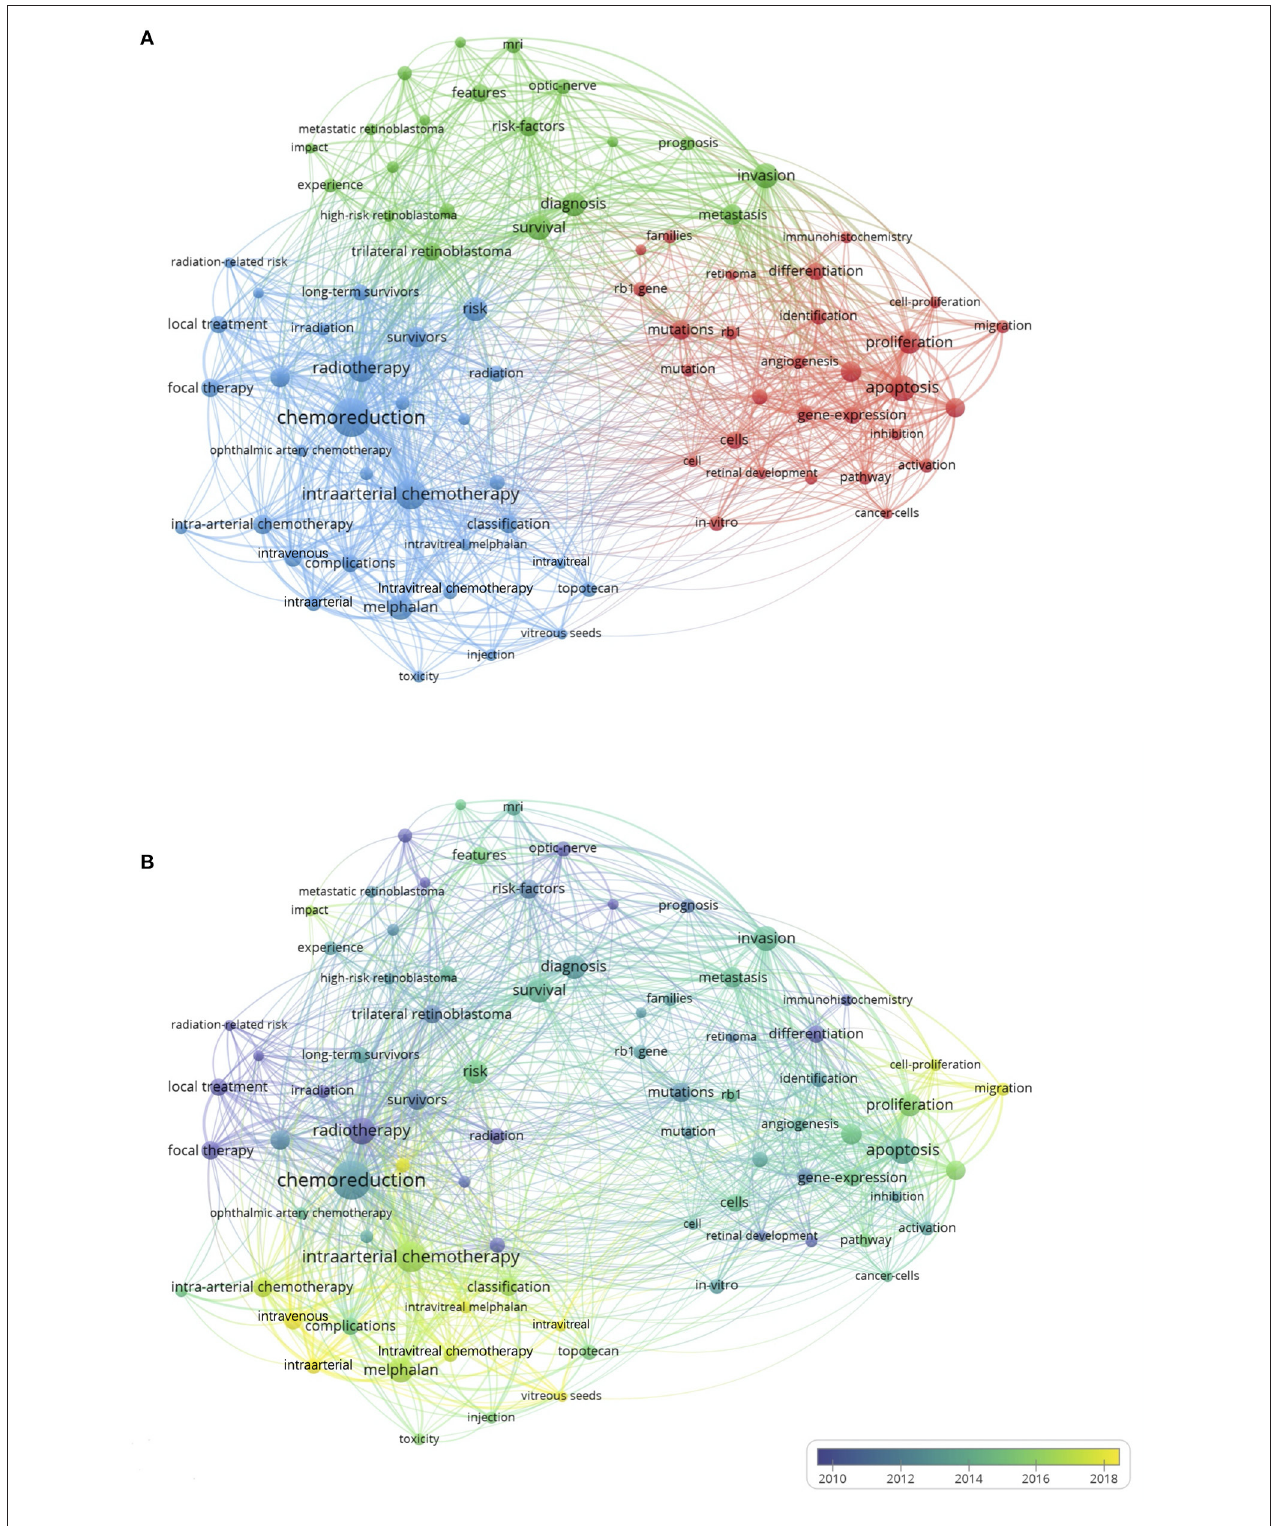
FIGURE 5 | Analysis of keywords in publications of retinoblastoma. (A) Mapping of the keywords in the field. All keywords were divided into 3 clusters and colored differently: tumor-related research (left in green), clinical research (right in red), and management-related research (up in purple). The circle with a larger size indicates a higher frequency of the keyword; (B) Distribution of keywords on the basis of the average appearance time. Yellow represents a recent appearance, and blue represents an early appearance. The line between two keywords represents their co-occurrence in the same publication, with a thicker line indicating a closer